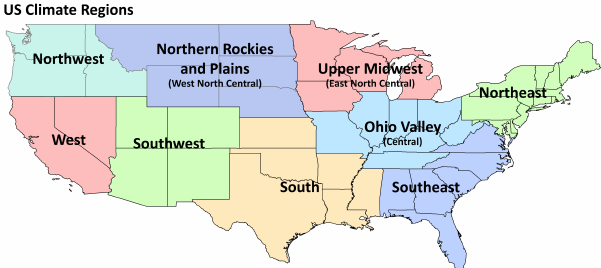
Figure 1. US climate regions identified by the National Climate Data Center (adapted from Karl and Koss, 1984, https://www.ncdc.